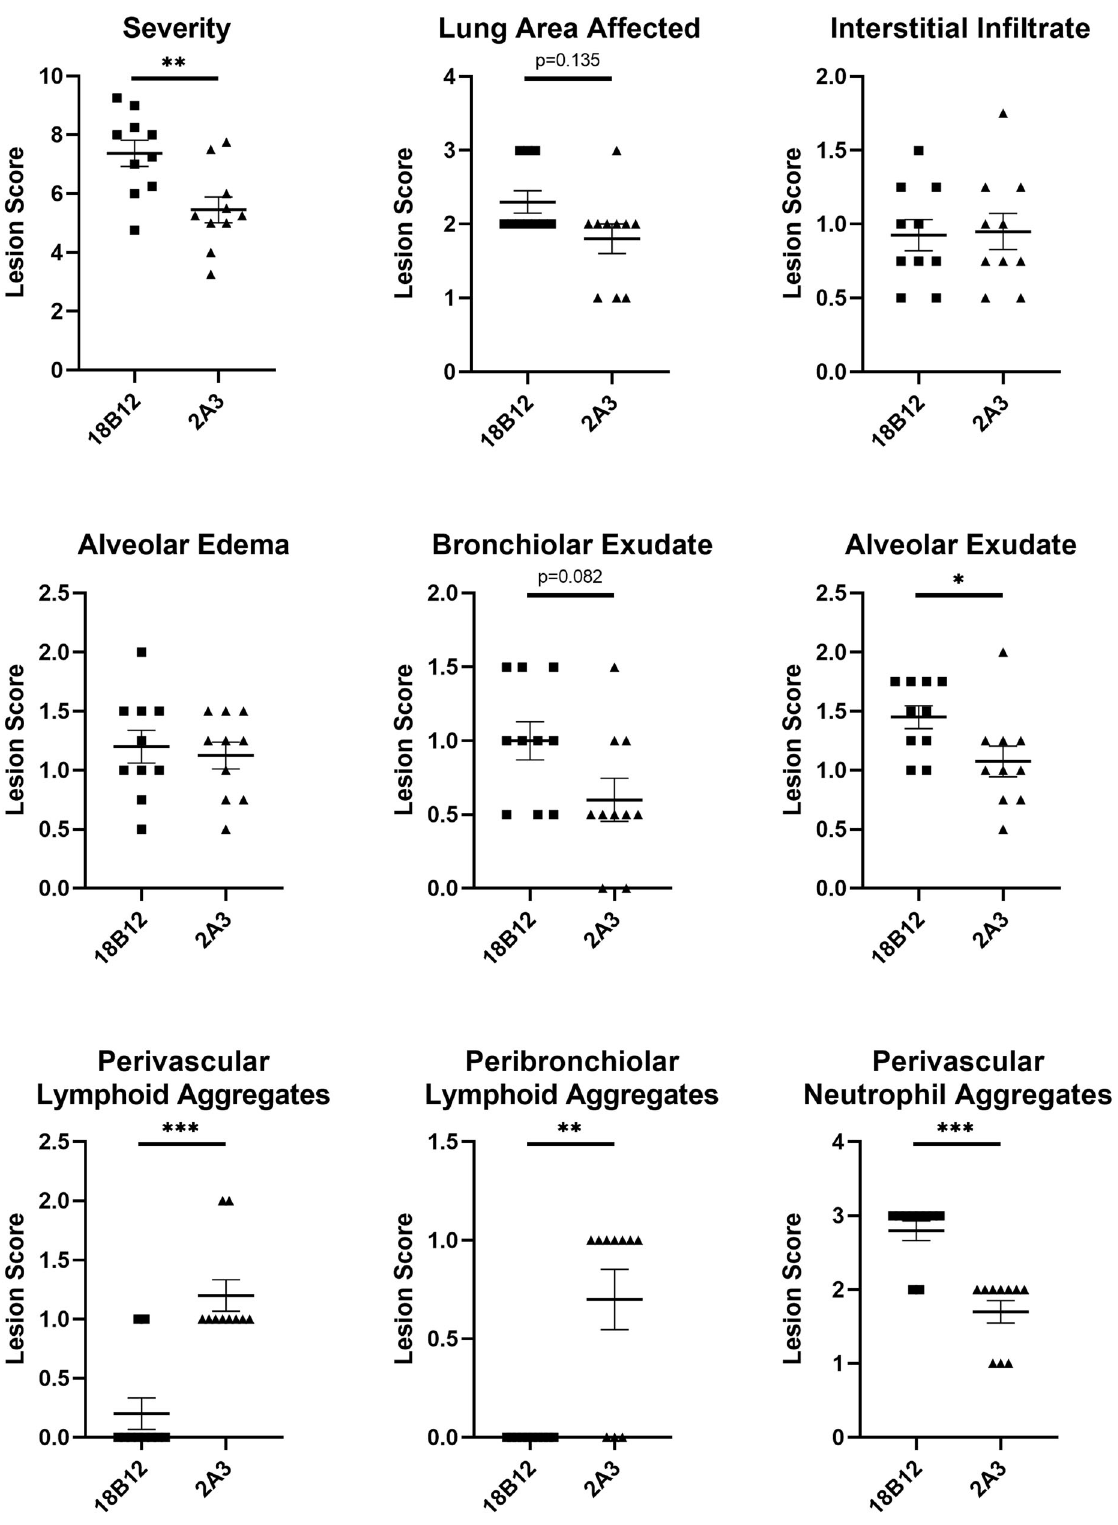
Fig. 5 Pathologic effects of B cell depletion on LAMP vaccination and infection. Histologic outcomes of mice vaccinated with M. pneumoniae LAMPs and pre-treated with the B cell depleting antibody 18B12.1 or the isotype control antibody 2A3. Severity score is the overall sum of interstitial in fi ltrate, alveolar exudate, alveolar edema, bronchiolar exudate, and perivascular neutrophil aggregate scores for individual animals. Data were analyzed using the Mann – Whitney test, displayed as mean plus and minus standard error of the mean, and differences were considered signi fi cant for p < 0.05 (* p < 0.05, ** p < 0.01, *** p <